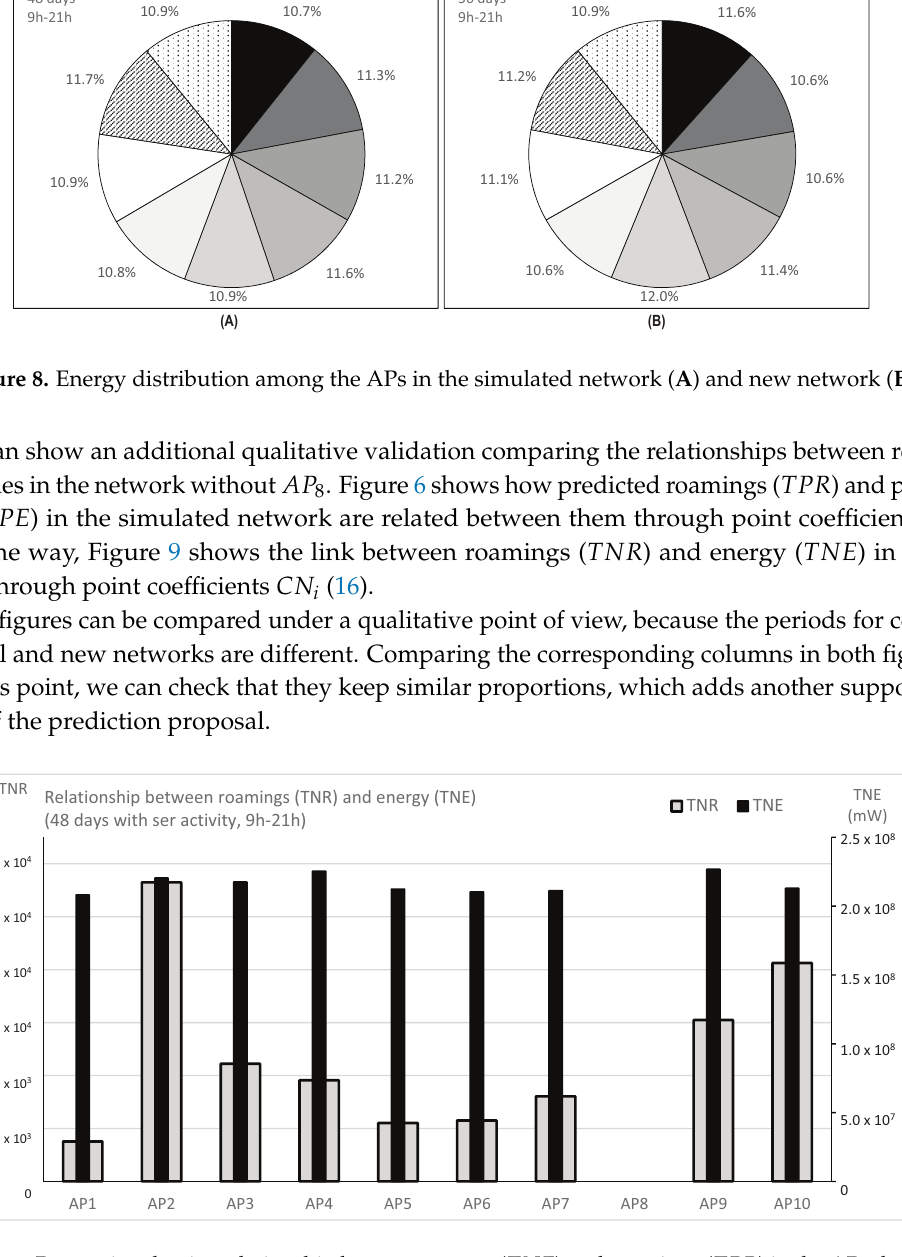
Figure 9. Proportional point relationship between energy ( TNE ) and roamings ( TPR ) in the APs during the period for the new network, given by the coefficients CN